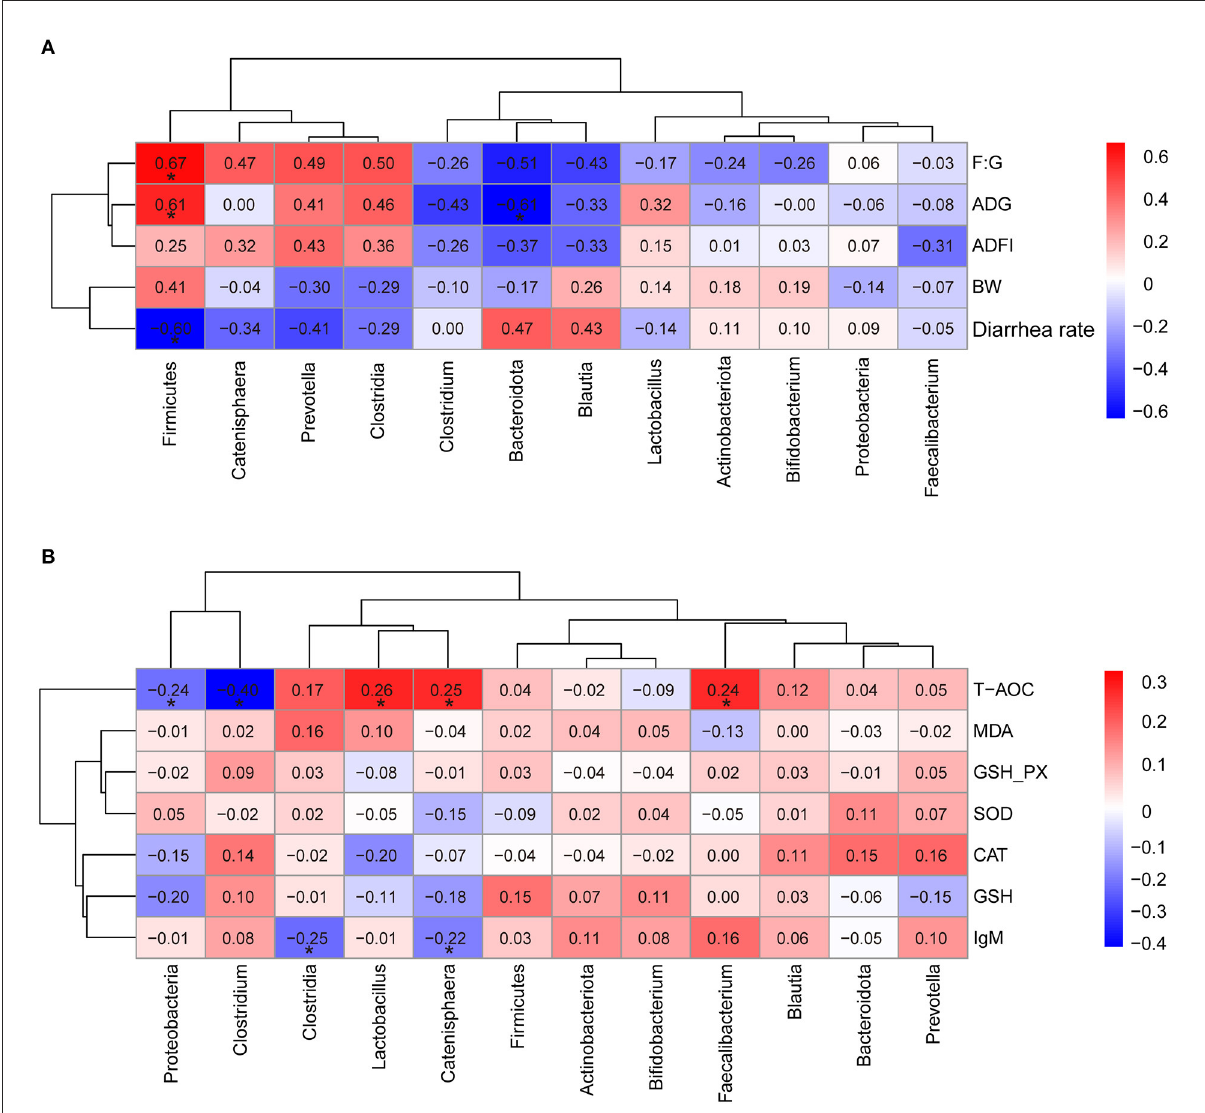
FIGURE6 Heatmap of the partial correlation analysis between the dominant microbial species and growth performance (A) , serum antioxidant parameters (B) . ADG, the average daily gain; ADFI, average daily feed intake; F: G, feed to gain ratio; T-AOC, total antioxidant capacity; MDA, malondialdehyde; GSH-PX, glutathione peroxidase; SOD, superoxide dismutase; CAT, catalase; GSH, glutathione; IgM, immunoglobulin M. The red represents positive correlation and the blue represents negative correlation, respectively (* p <